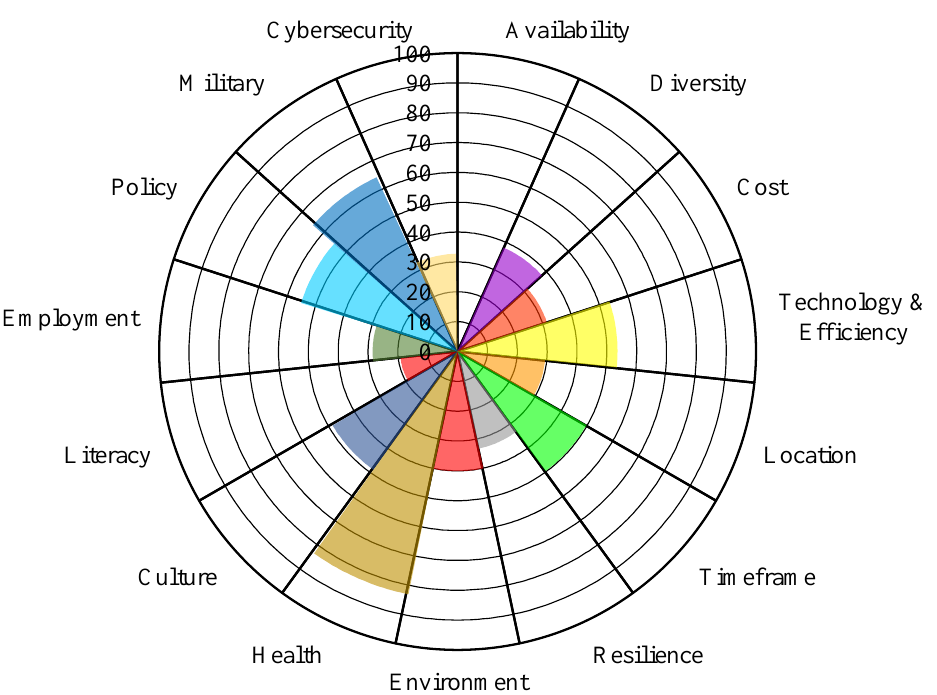
Figure 21. Detailed energy security view for Jordan, values 0–100 represent worst to best.